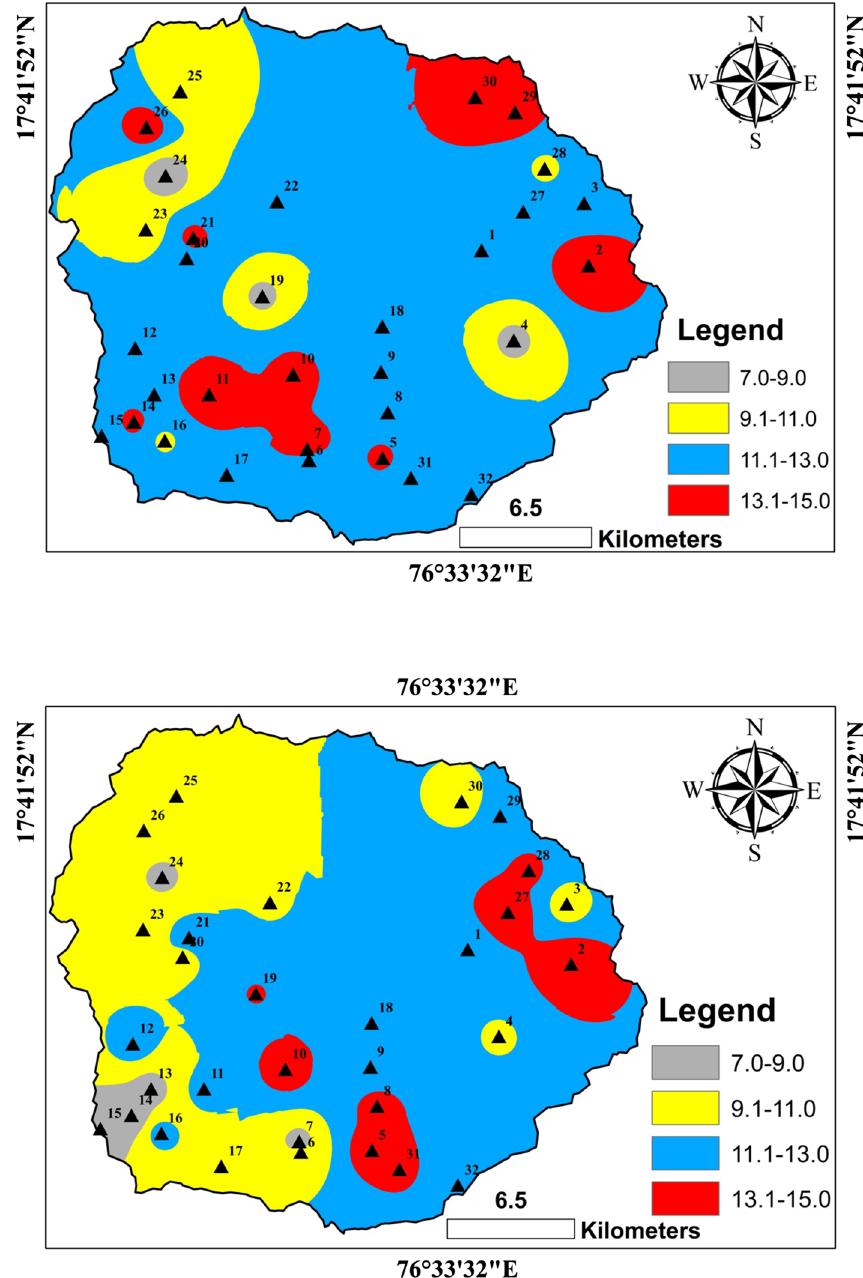
Fig. 12 Geospatial distribution of sodium (pre-monsoon)